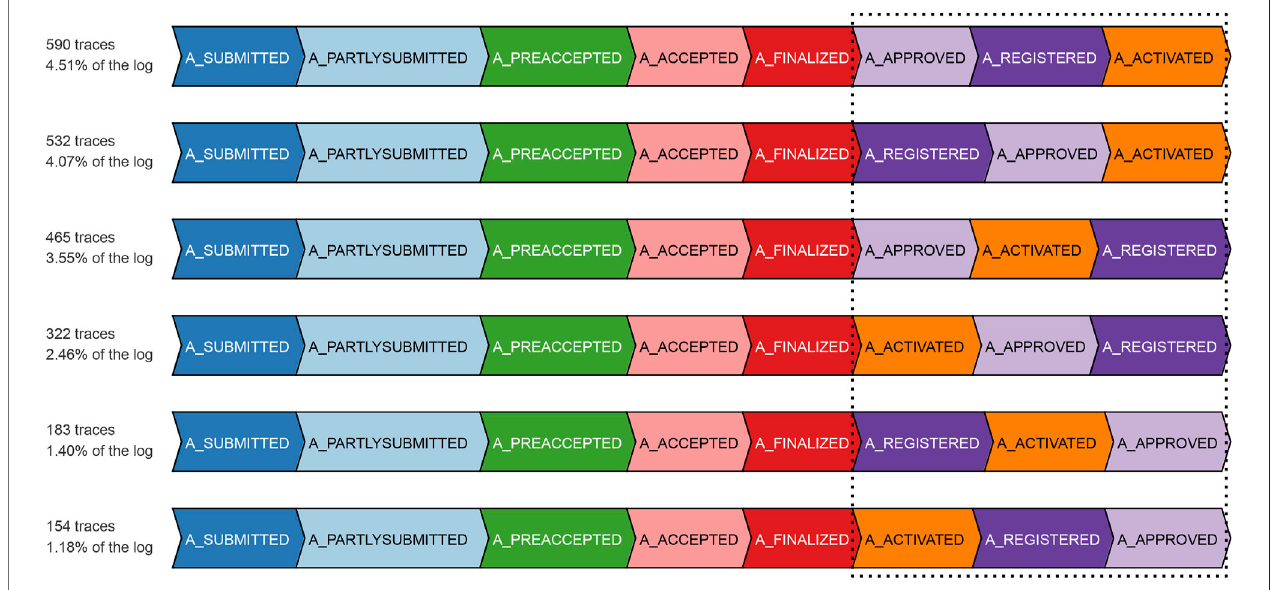
FIGURE 8 | Cases with a pre fi x length of at least 6 in the application process of the BPIC ’ 12 event